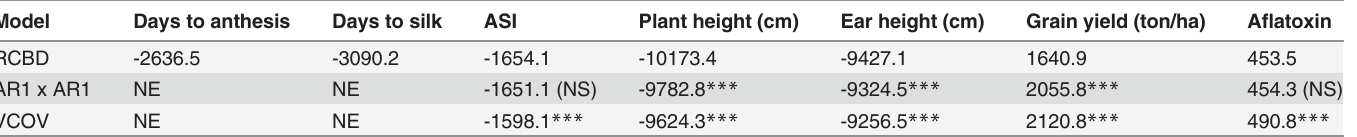
Table 3. Comparisons of different models used in this